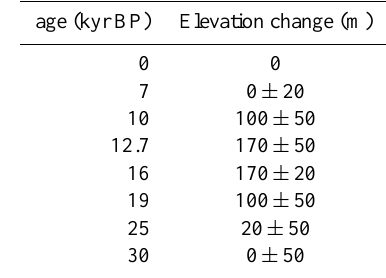
Table 5. Estimated elevation changes (positive numbers indicate an increase) in the TALDICE area between 0 and 30kyr BP. Error bars are estimated from literature descriptions (Stenni et al.,